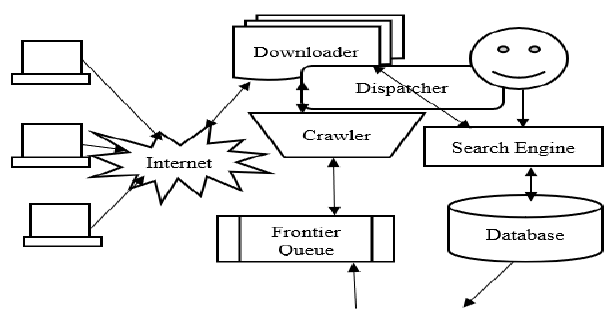
Figure 1: Working of Web